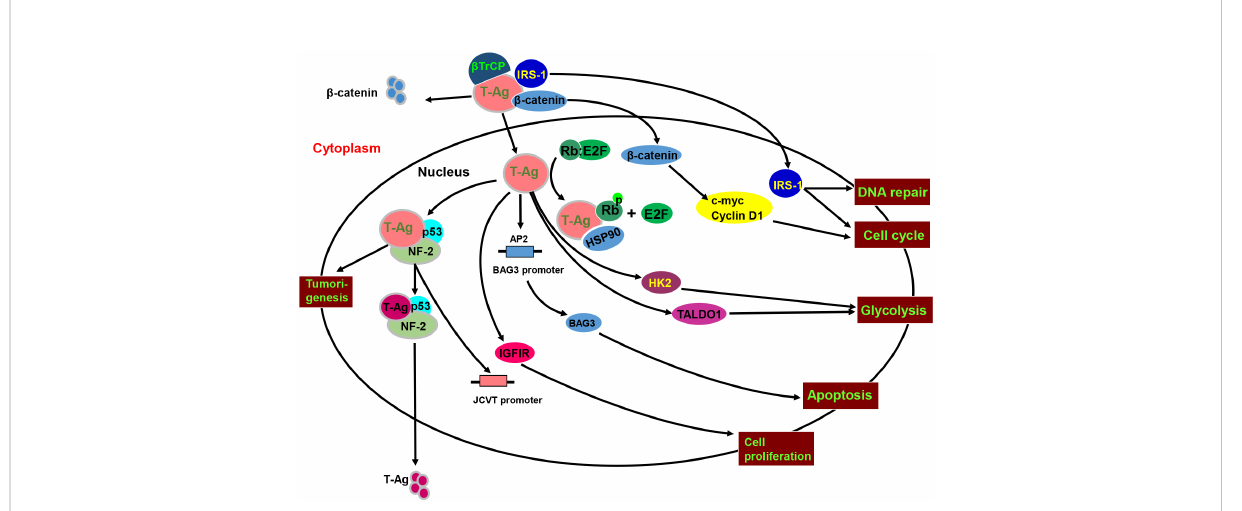
FIGURE 4 The biological function and signal pathways of the JCPyV T antigen. JCPyV T antigen binds to b TrCP1/2 protein to cause ubiquitin-mediated degradation of b -catenin, and binds to b -catenin to enhance its protein stability and facilitate its entry into the nucleus. Nuclear b -catenin promotes S-phase transformation by up-regulating c-myc and Cyclin D1 protein expression. T antigen interacts with p53 and neuro fi bromatosis- 2 (NF-2) for the proteasome-mediated degradation of T antigen. The binding of T antigen to phosphorylated Rb protein results in the separation of Rb-E2F, resulting in an abnormal cell cycle. T antigen can promote the translocation of the insulin receptor substrate 1(IRS1) to the nucleus, induce cell cycle evolution, and participate in DNA repair. In addition, T antigen up-regulates the expression and phosphorylation of IRS1 and IGF1 receptor (IGF-1R), promoting cell proliferation and disrupting normal cell activity by binding to the transcription factor AP-1. The DNA binding domain of T antigen can bind to the AP2 sequence in the BAG3 promoter and CPG binding protein promoter of transcriptional regulatory methylation and regulate the expression of BAG3. T antigen can also stimulate the expression of transaldolase-1 (TALDO1) and hexokinase-2 (HK2) to induce